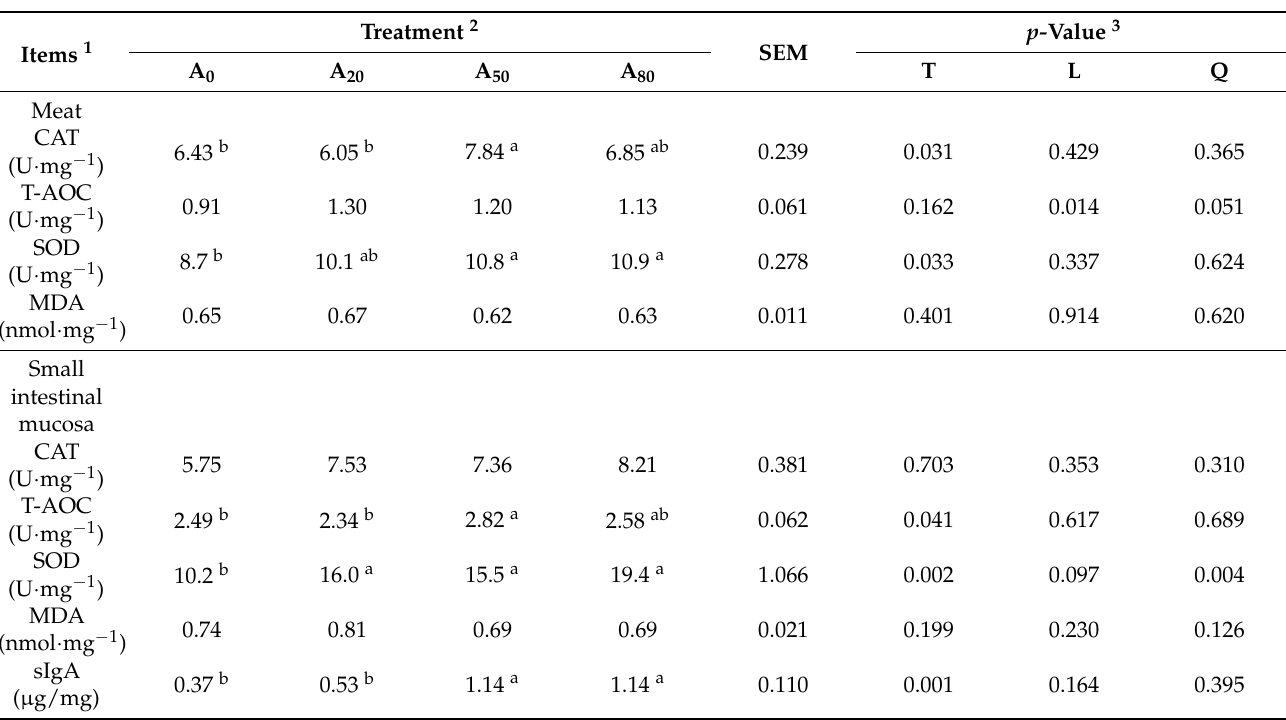
Table 5. The effect of supplementary Astralagus membranaceus (AMT) on antioxidant indices in meat tissue and small intestinal mucosa of Tibetan